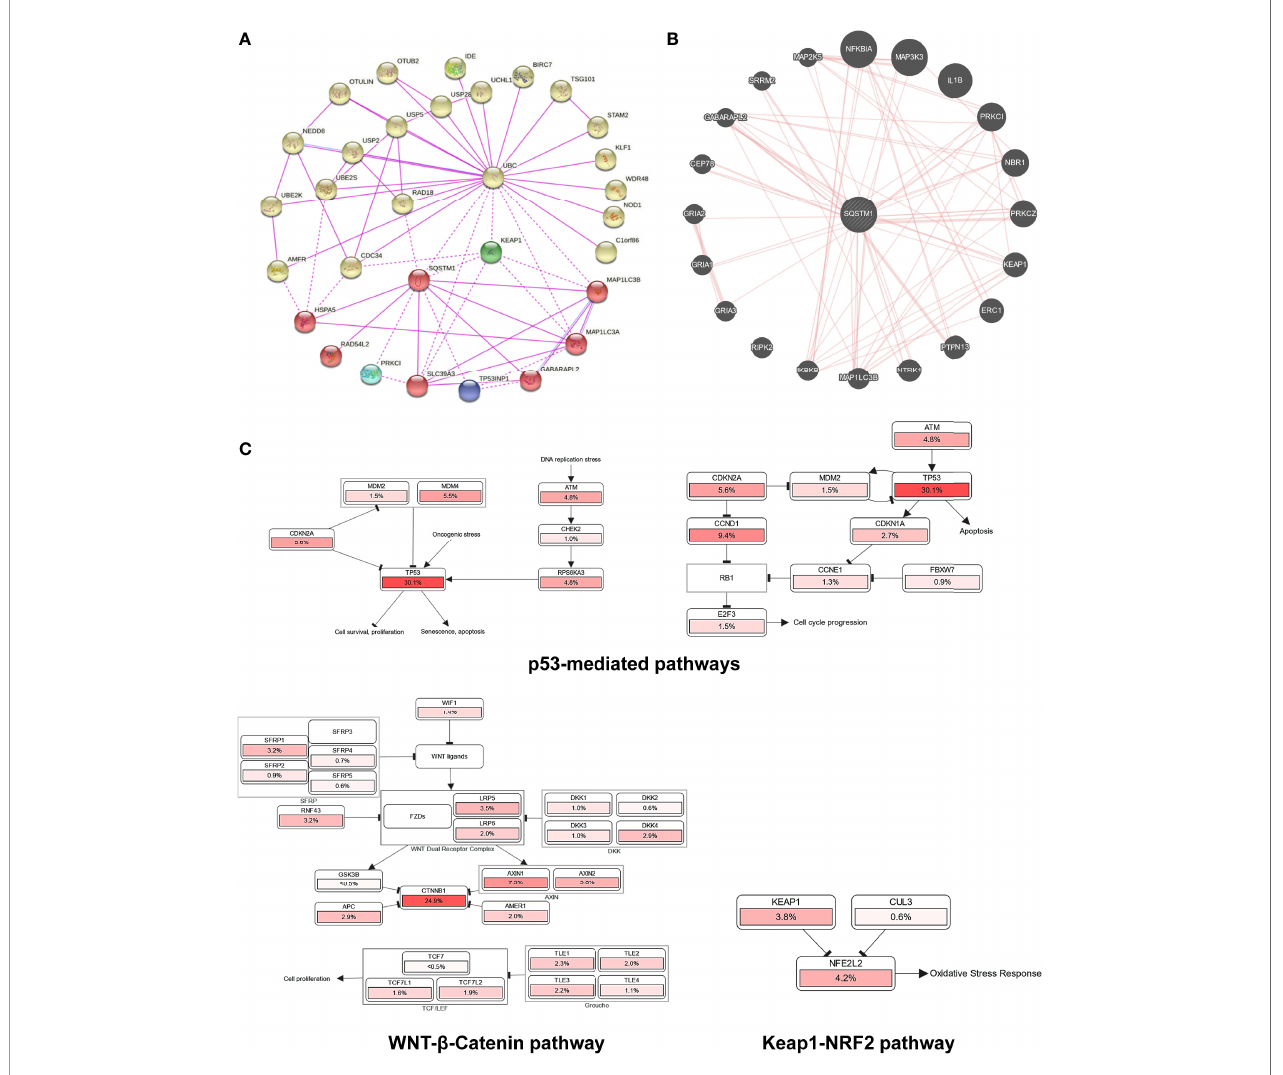
FIGURE 9 | Genome-wide interaction and pathway association of Sqstm1 in LIHC. (A) Known SQSTM1 protein physical interaction network, as analyzed in STRING databases. Co-expression, textmining, neighborhood, and gene fusion were excluded in the settings. (B) Physical interactors of SQSTM1 protein as identi fi ed in BioGRID with various databases from both high and low throughput assays. (C) The pathways that are deregulated in correlation with SQSTM1 in LIHC. The deregulation of individual genes is shown in red. The more frequently a given gene is deregulated, the deeper red is